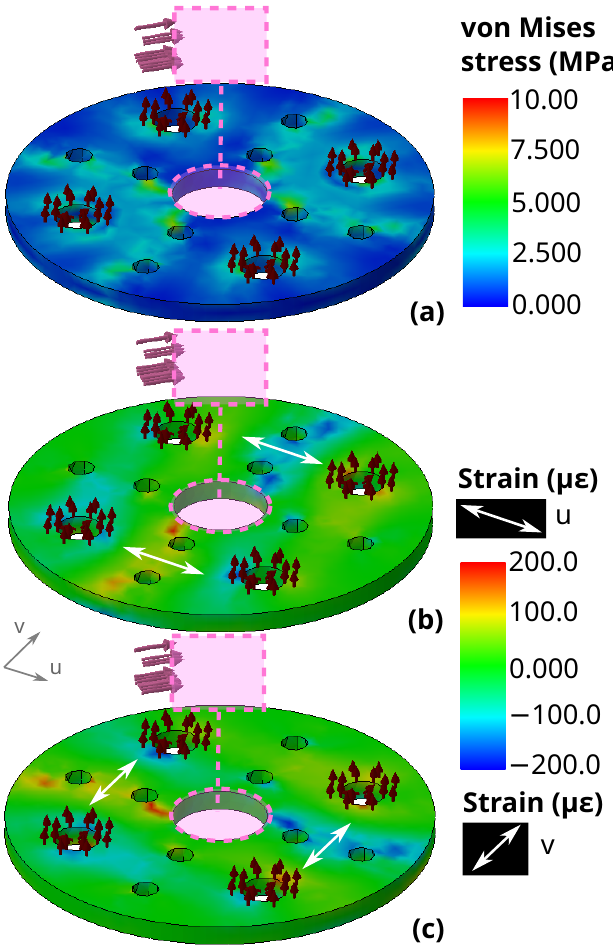
Figure A2. FEA simulation of a 10.0 N force in the Y-direction applied 15.5 mm from the center of the 3-DOF sensor. Applied forces are represented by pink arrows with the moment arm in dashed pink lines, while support fixtures are represented by brown arrows. Surface coordinates u and vs. are represented by a grey frame. All results are viewed from top surface. Results include ( a ) von Mises stress field, ( b ) u-direction strain, and ( c ) v-direction strain fields. The axis being referenced for strain measurement is indicated by a white bidirectional arrow on the surface of the sensor at the gauge locations. The two strain axes are perpendicular, but are offset from established X-Y axes by 45